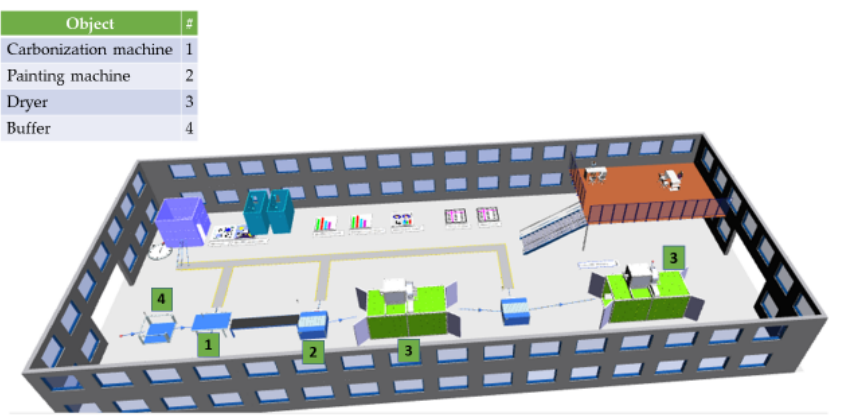
Figure 4. Shou Sugi Ban area, built through Siemens Plant Simulation.